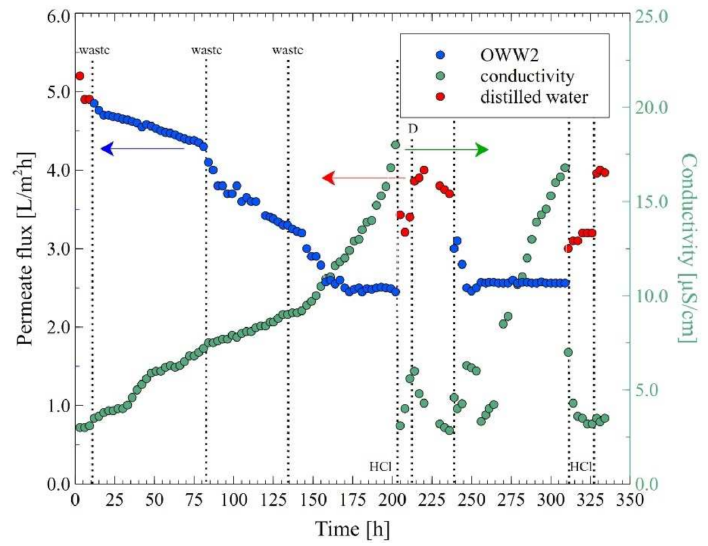
Figure 21. Changes in the permeate flux and distillate conductivity in the MD process with periodic washing of the membranes. Feed: oily wastewater OWW2, T F = 343 K, v F = 0.12 m/s. Module M7.